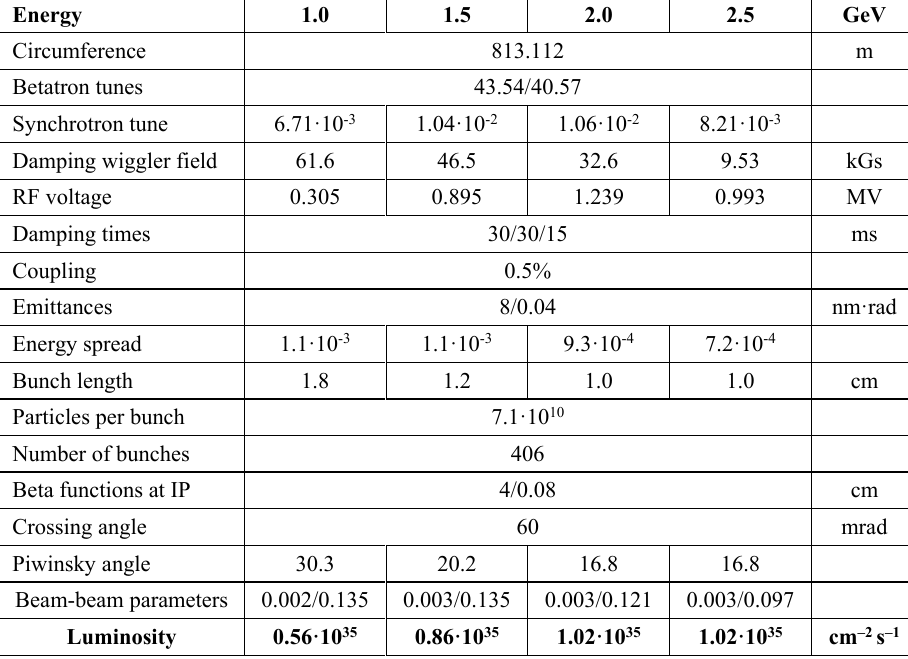
Fig. 6 . Super Charm Factory layout. Table 4 . The main parameters of the Super Charm Tau